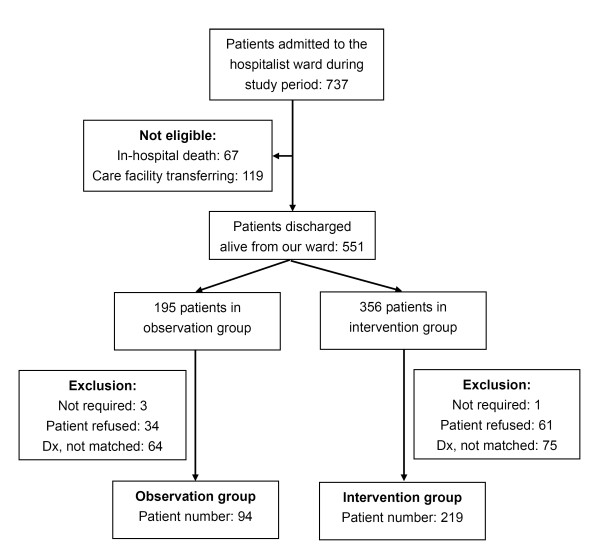
Flowchart of patient enrollment. "Not required" indicates a patient with no chronic illness and a Barthel Index score ≥60; "Dx, not matched" means the patient's diagnosis did not match the enrolled disease items; "Patient refused" means the patient refused enrollment.